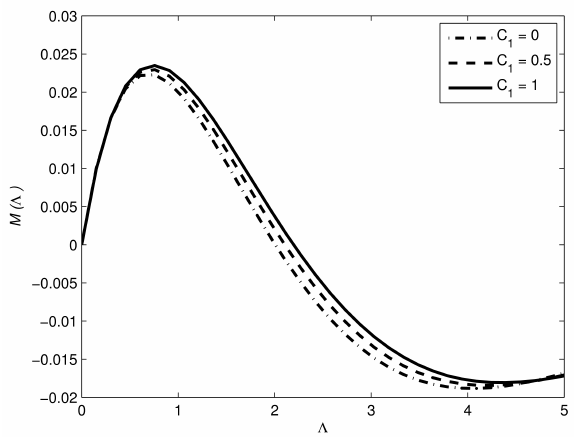
Figure 3: Effect of C 1 on G ( Λ ) keeping ζ = η = 0.2 , C 2 = C 3 = 1 , Pr = 6.8 , Br = 1 and Re = 2950